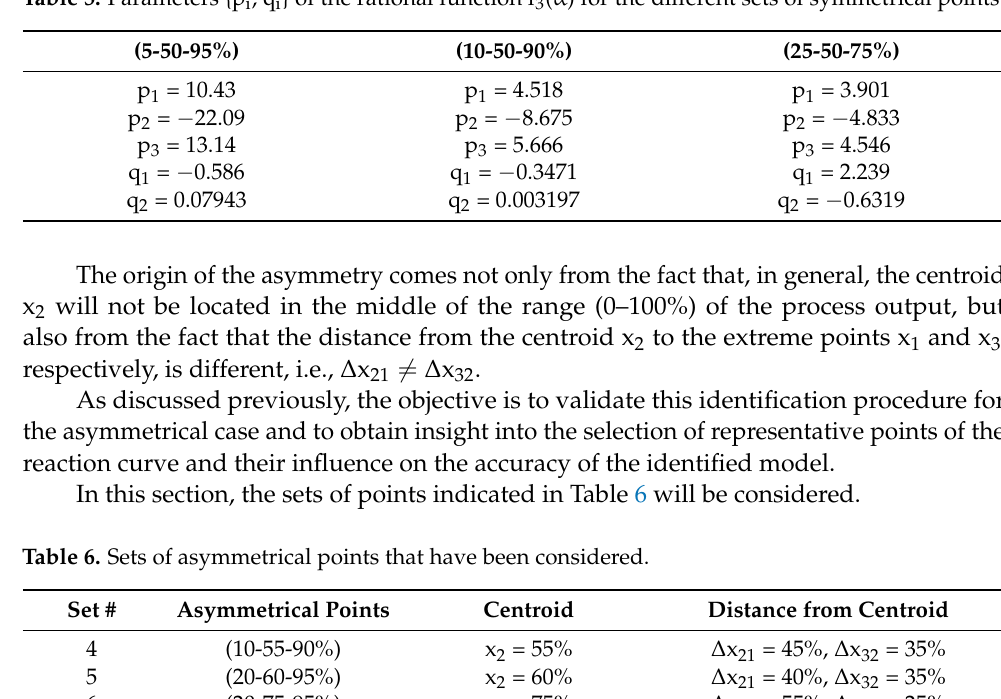
Table 5. Parameters {p i , q i } of the rational function f 3 ( α ) for the different sets of symmetrical points.